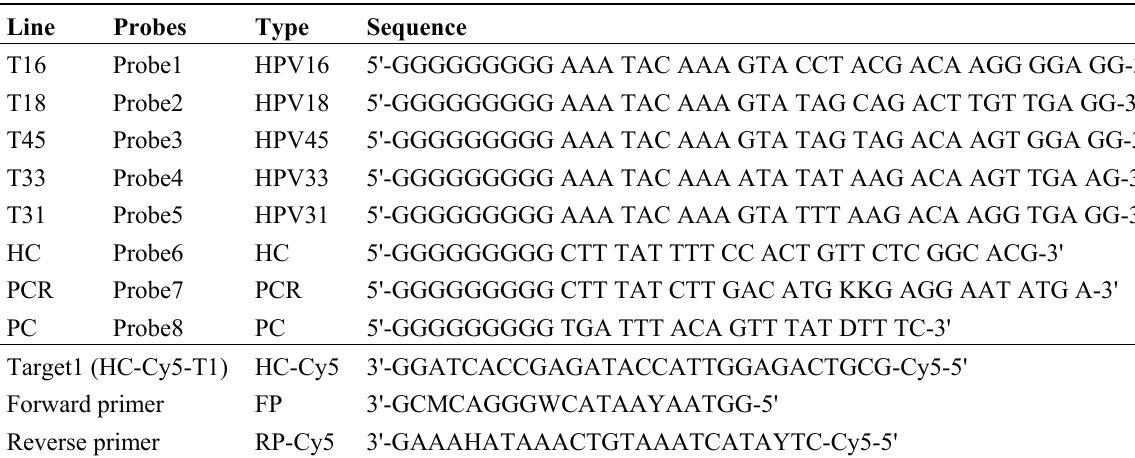
Table 1. Sequences of the probes immobilized on the HPV genotyping 9G membranes.